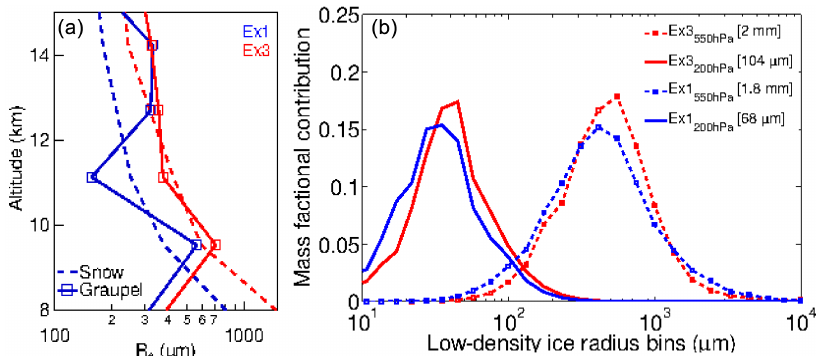
Figure 9. (a) Simulated mean snow (dashed) and graupel (open square symbol connected by solid line) R e for low- (Ex1, blue) and high- (Ex3, red) CCN scenario. (b) Simulated size distribution spectra of low-density ice particles for Ex1(blue) and Ex3 (red) at 550hPa (solid lines) and 200hPa (dashed lines). The fractional contribution is calculated by dividing the mass concentration of each bin with the total mass